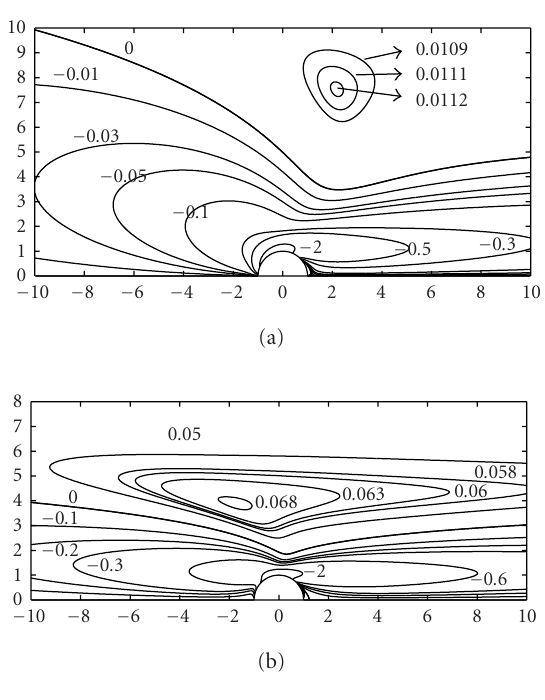
Figure 4.5 . Isocontours of vorticity for (a) Re = 40, N = 1 and (b) Re = 40, N =